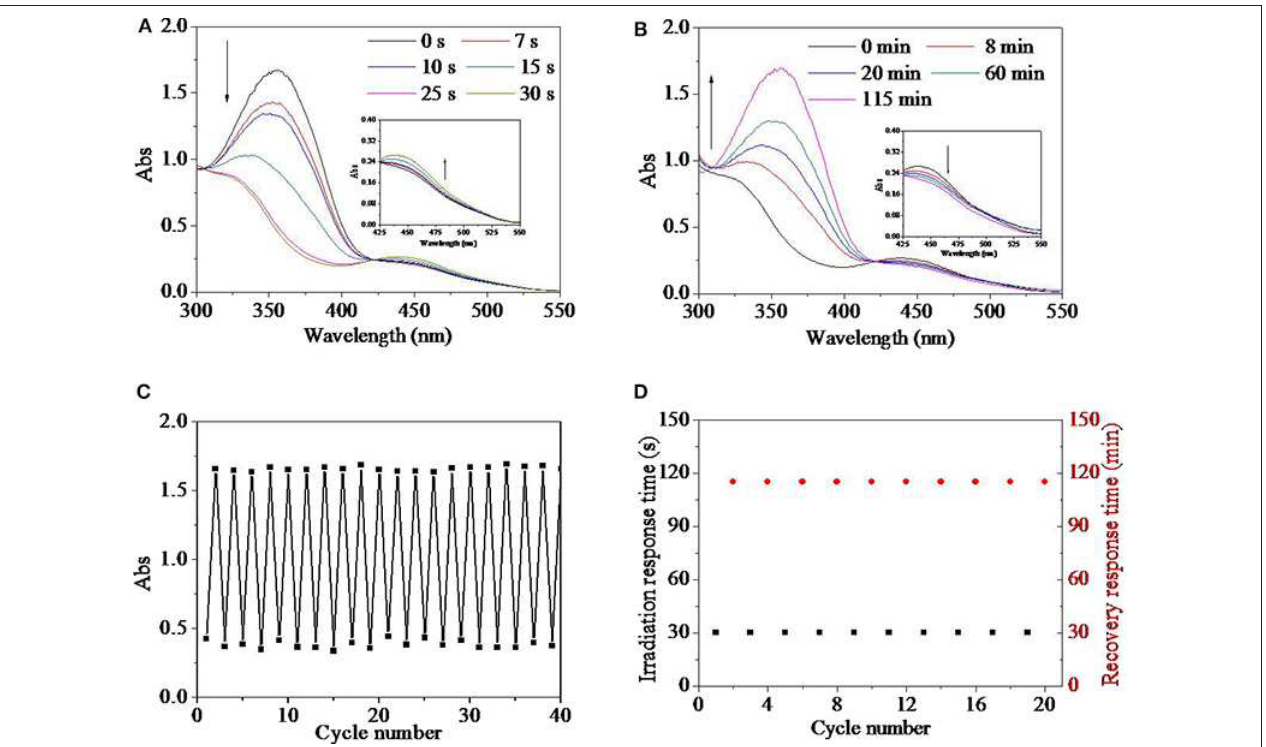
FIGURE 4 | UV spectra of the HEMA-NVP-AZO terpolymer dimethylsulfone (DMSO) solution as a function of (A) irradiation time and (B) recovery time. (C) Absorbance at 360nm of the HEMA-NVP-AZO copolymer DMSO solution as a function of cycle number. (D) Irradiation response time under UV irradiation and recovery-response time under 73 µ W/cm 2 white light as a function of cycle number at 20 ◦